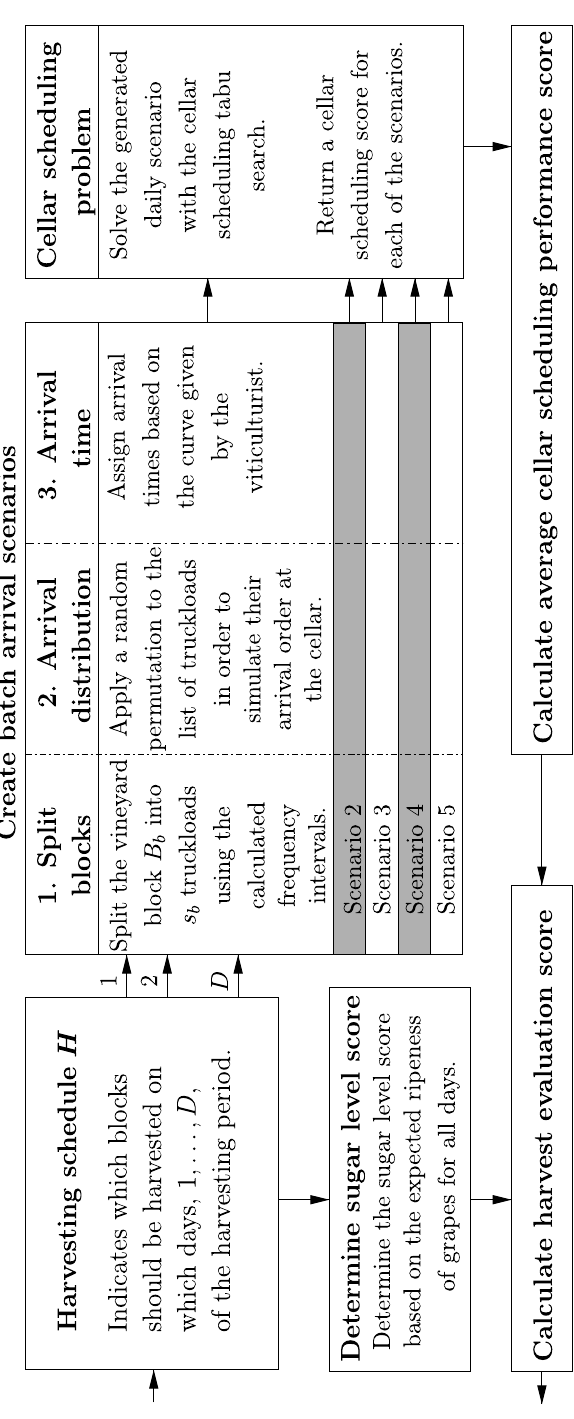
Figure 1: The three phases of an iteration of the over-arching harvest scheduling problem tabu search: (1) The generation of a daily vineyard block harvest selection strategy, (2) the stochastic generation of a number of daily grape truckload or batch arrival scenarios, and (3) solving the active cellar scheduling problem approximately via the inner tabu